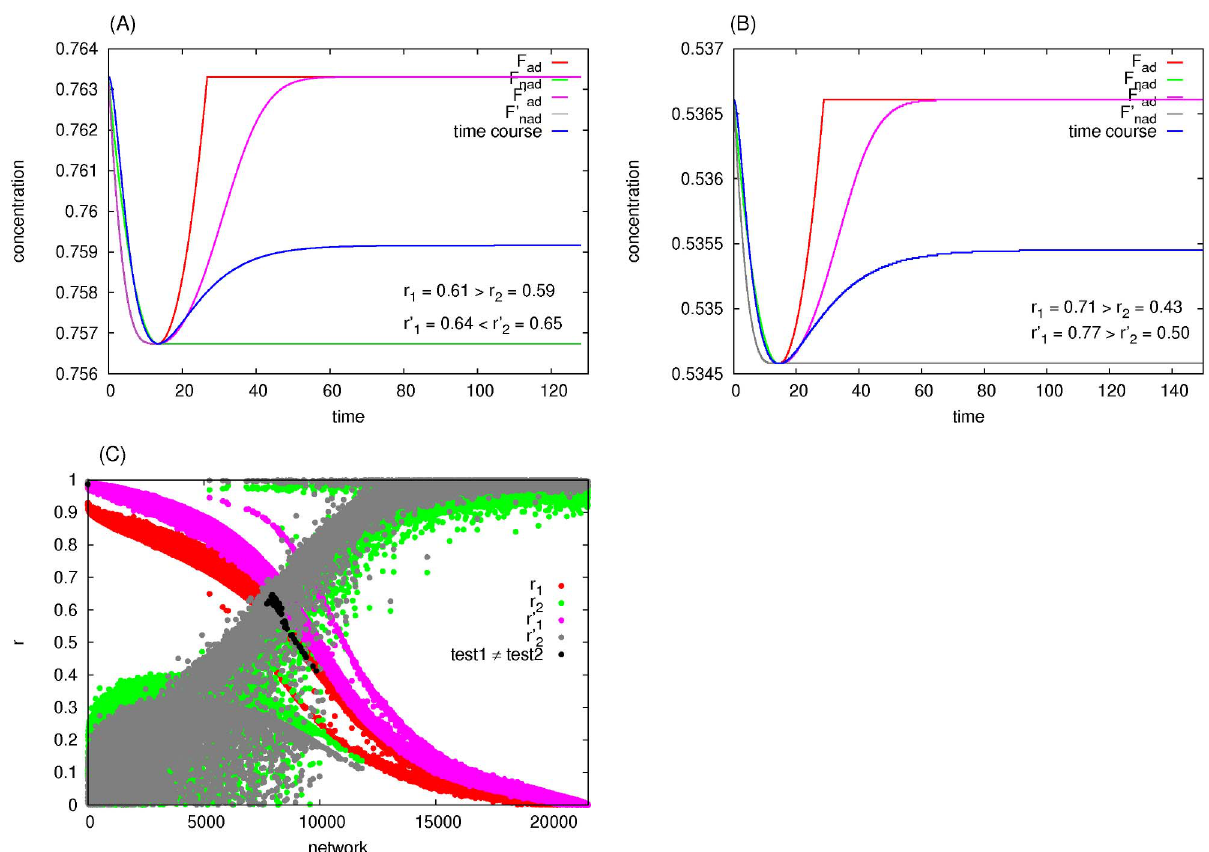
(pink) and F 0 ad nad w r 0 ). In (C) we show all r 1 (red), r 2 1 2